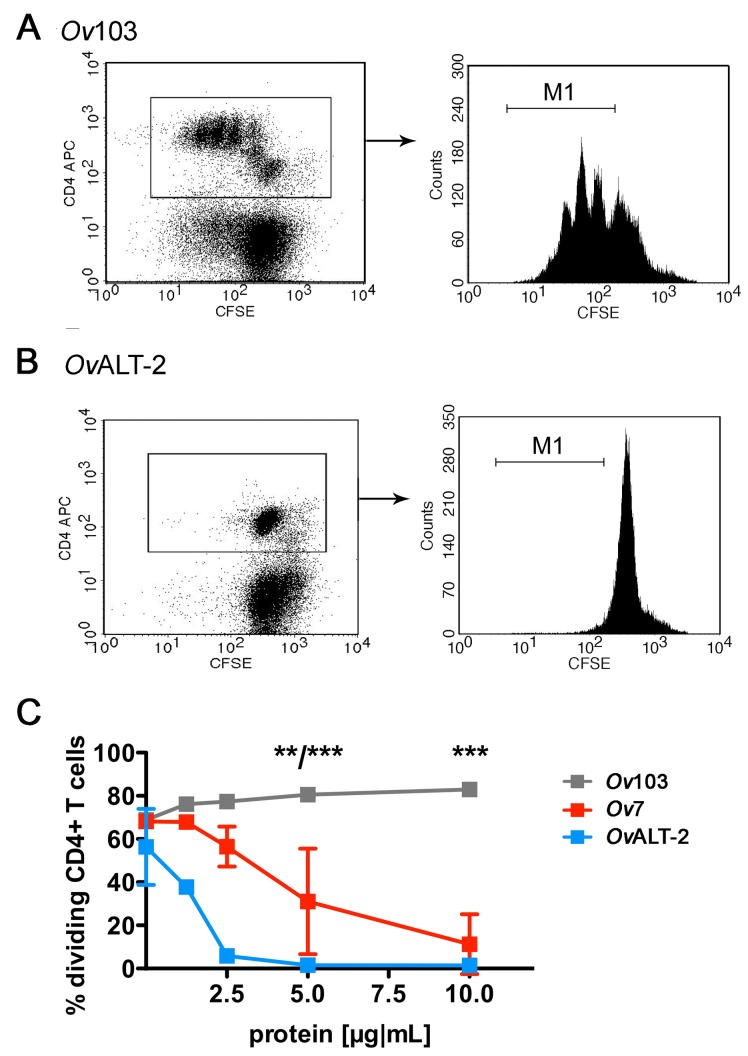

OvALT-2 suppresses OVA-specific OT-II T cell
proliferation in
vitro.
Spleen cells were isolated from OT-II mice and labeled with CFSE. Cells
were stimulated with 50 ng/mL OVA323-339 peptide in the
presence of nematode-derived proteins Ov103,
OvALT-2 or Ov7 in increasing
concentrations as indicated on the x-axis. After 72 h cells were stained
with anti-CD4 mAb and proliferation of CD4+CFSE+ T
cells was analyzed by flow cytometry as percentage of dividing T cells
(marker M1). Shown is a representative dot blot of OT-II spleen cells
after incubation with 7.5 µg/mL Ov103 (A) or
OvALT-2 (B) in the presence of OVA-peptide. C)
Graph shows percentage of dividing T cells in the presence of indicated
concentration of ESP. Data are presented as the mean of combined results
derived from two independent experiments, error bars show SEM. Asterisks
indicate significant differences in the mean of Ov103
to Ov7 or OvALT-2, respectively (** p
< 0.01; *** p < 0.001).